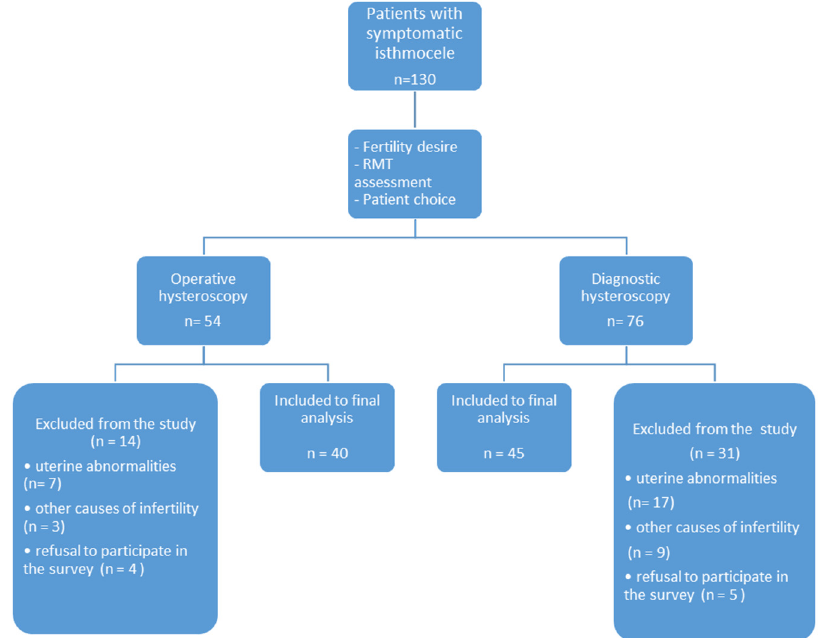
Figure 1. The scheme of the study. RMT: residual myometrium thickness.